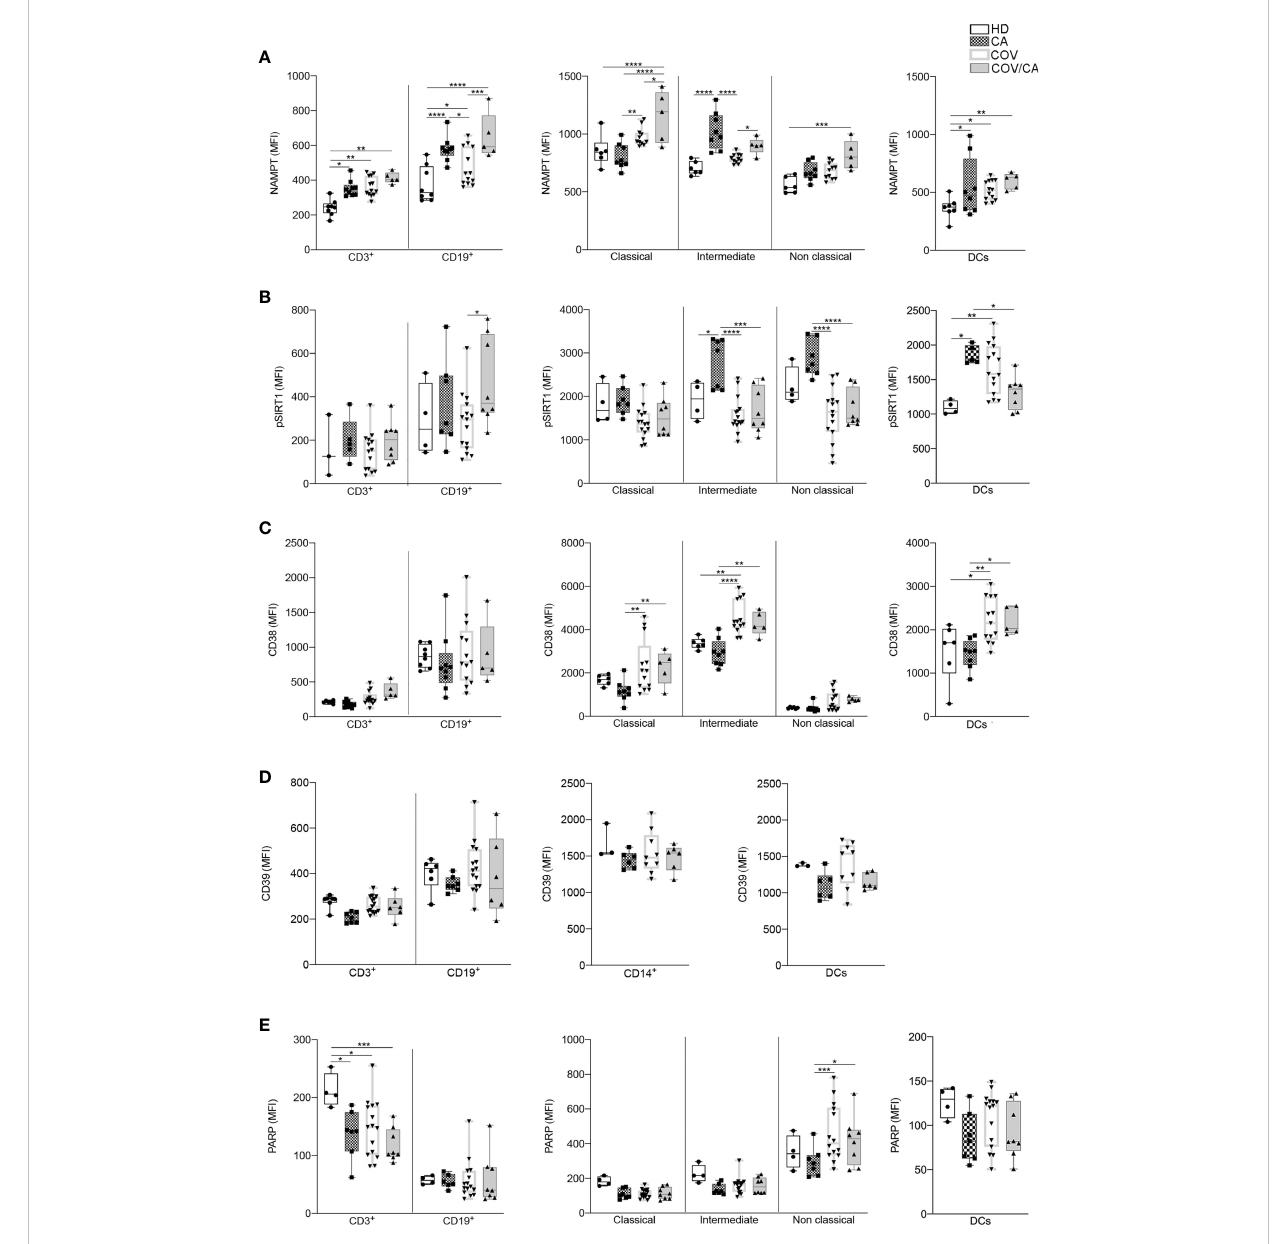
FIGURE 9 Flow cytometry analysis of NAMPT and NAD-dependent enzymes in the different patient cohorts. Box-and-whisker plots representing FACS quanti fi cation of (A) NAMPT, (B) pSIRT1, (C) CD38, (D) CD39 and (E) PARP expression in the indicated immune cell populations (CD3 + T cells, CD19 + B cells, DCs and monocytes subsets). Samples were freshly isolated PBMCs from HD ( n =8), CA ( n =9), COV ( n =13) and COV/CA (n=5) patients. Boxplot representation (centre line, mean; box limits, upper and lower quartiles; whiskers, range; points, data points per patient). (A) HD ( n = 6 or 8), CA ( n = 8), COV ( n = 12 or 13) and COV/CA ( n = 5) patients. (B) HD ( n = 3 or 4), CA ( n = 5 or 7), COV ( n = 15) and COV/CA ( n = 8) patients. (C) HD ( n = 6), CA ( n = 8), COV ( n = 13) and COV/CA ( n = 5) patients. (D) HD ( n = 3 or 4), CA ( n = 6 or 7), COV ( n = 9 or 15) and COV/CA ( n = 6) patients. (E) HD ( n = 4), CA ( n = 6 or 7), COV ( n = 15) and COV/CA ( n = 8) patients. Statistical signi fi cance of differences between patient groups was calculated using two-way ANOVA with Sidak ’ s multiple comparisons test. * P < 0.05, ** P < 0.01, *** P < 0.001, **** P < 0.0001 between selected relevant